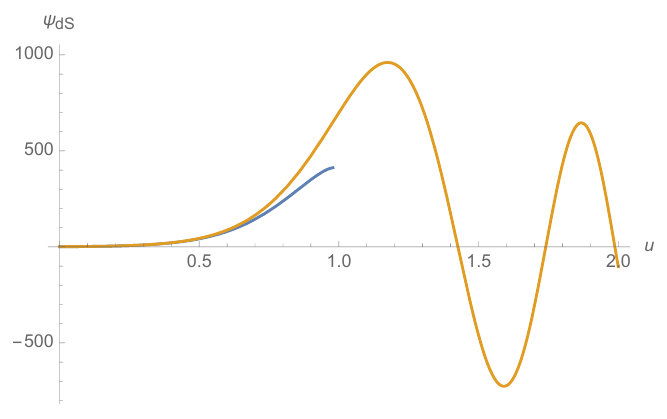
Figure 1 . WKB and exact solutions (blue and orange, respectively) to (4.46) for η = − 1 and c = 10 . h T ¯ T i ≈ h T ih ¯ T i , which is valid at large c with λc fixed. This is equivalent to the